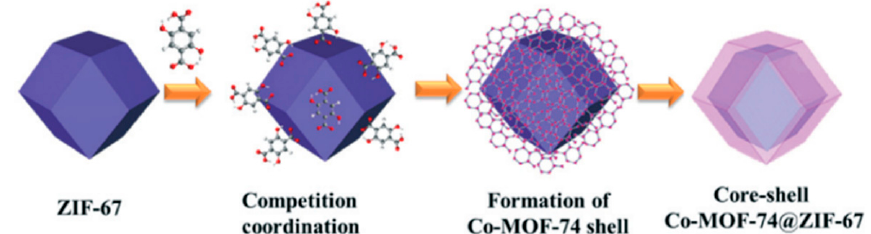
Figure 6. The synthesis of Co-MOF-74@ZIF-67 composite for water oxidation (Reprinted with the permission [105]. Copyright 2018 The Royal Society of Chemistry).